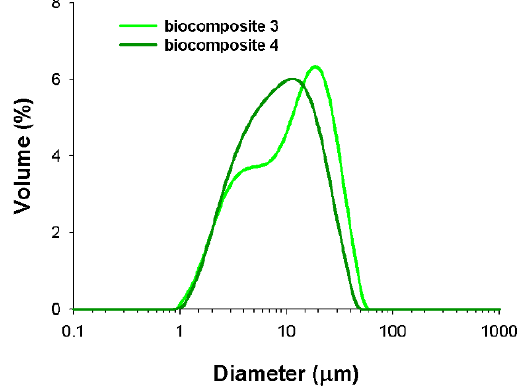
Figure 4. Particle size distributions of two selected biocomposites (Mastersizer 2000).